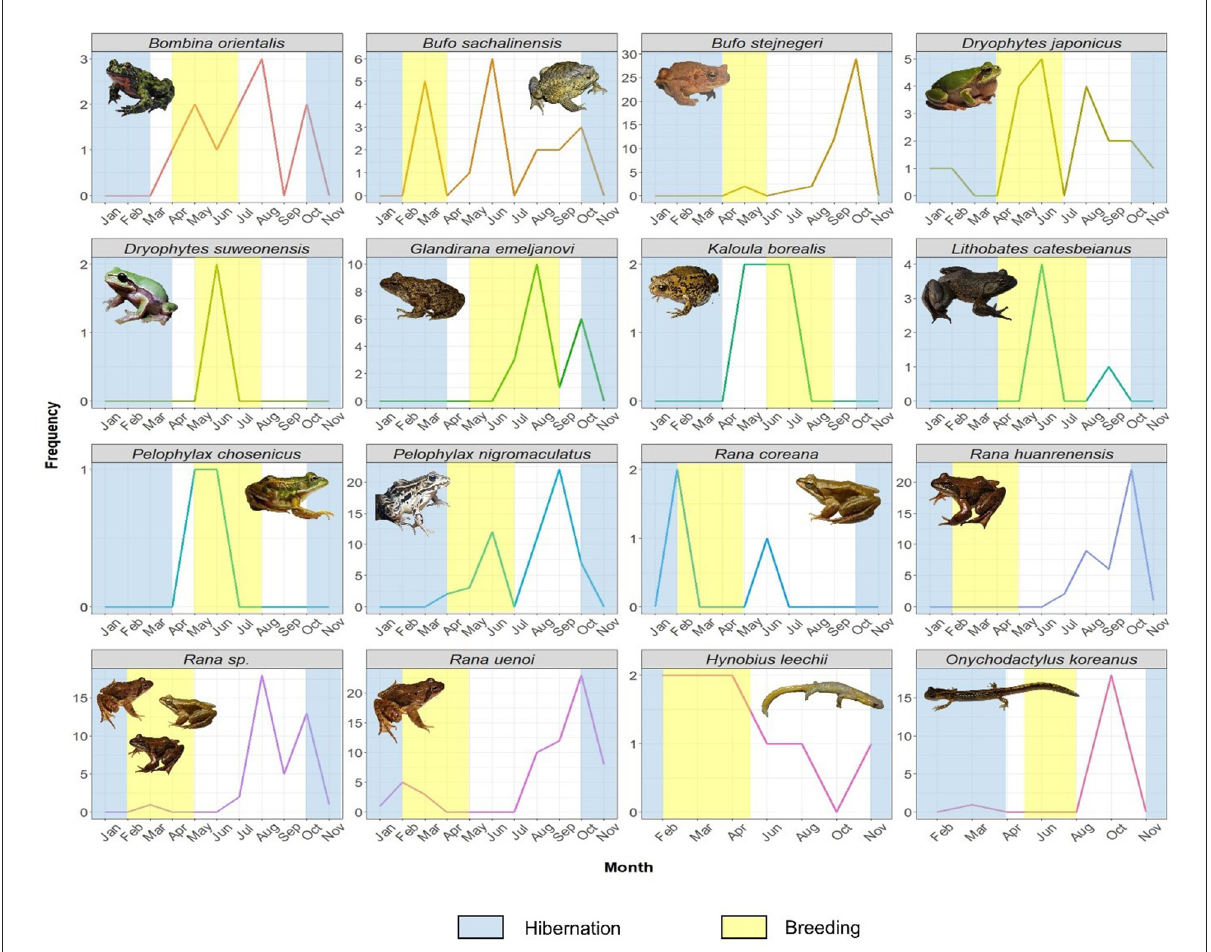
FIGURE5 The monthly roadkill trends for Korean amphibians ( n 361), based on iNaturalist observations. The roadkill records were collected from 1 = January 2005 to 13 August 2021 through the iNaturalist project “Herpetofauna Roadkill in the Republic of Korea”. Ambiguous observations with identifications above the genus level were excluded. The information on breeding season and hibernation period for each species is based on Lee and Park (2016), and summarized in Supplementary Table 2. Photographs of amphibians by